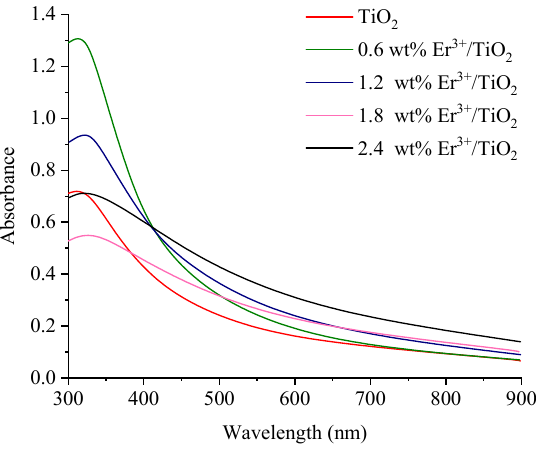
Figure 5. Ultraviolet–visible spectra of the synthesized NPs.